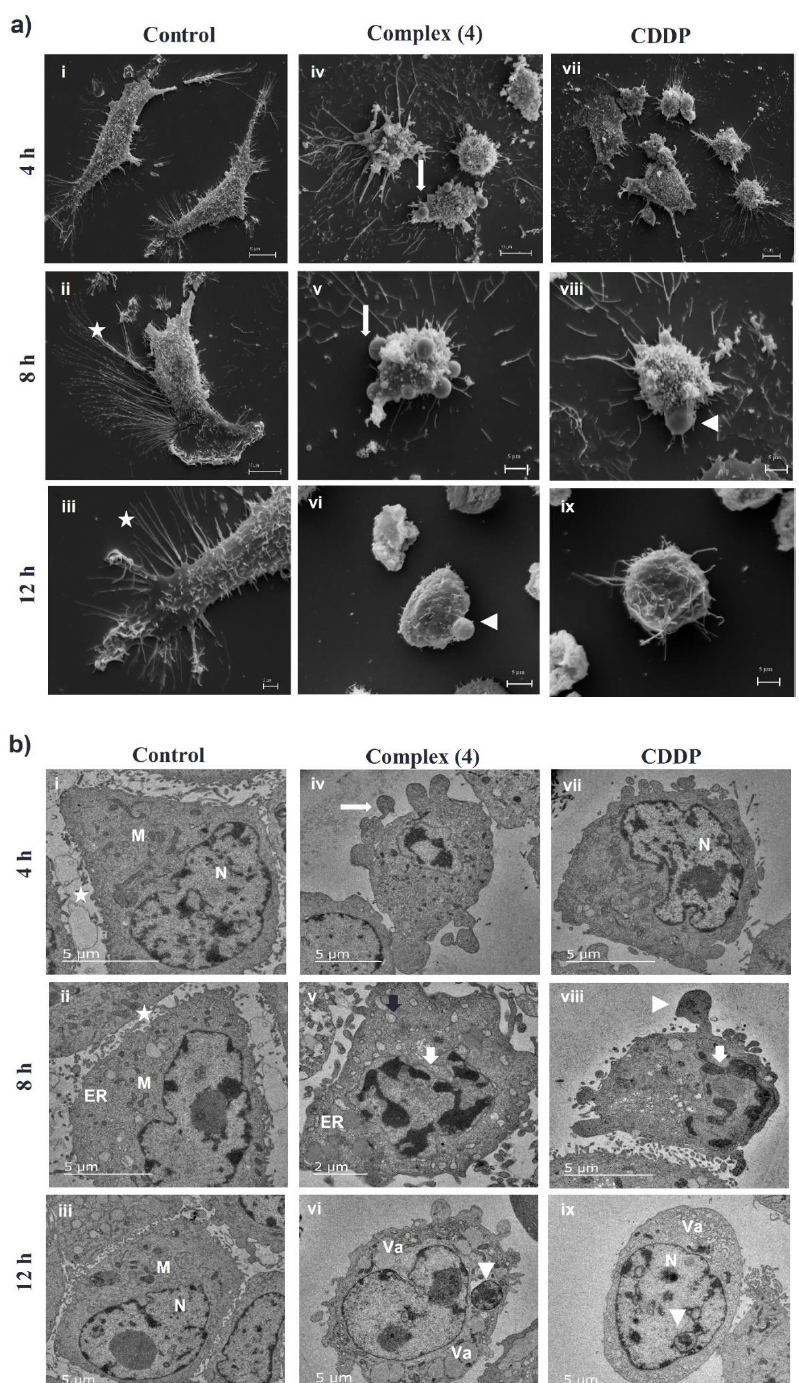
Figure 6. Ultrastructural analysis of MDA-MB-231 cells treated with 2 × IC 50 of complex ( 4 ) and cisplatin after 4, 8, and 12 h of incubation in comparison to the controlled group. ( a ) The top panel shows representative SEM micrographs of the compounds’ effect on the surface of the MDA-MB-231 cell line. ( b ) The bottom panel shows representative TEM micrographs of the compounds’ effect on the intracellular organelles of MDA-MB-231 cell line. Numerous villi are shown (star) on the cell surface. Cells with intense membrane blebbing (thin white arrow). The release of apoptotic bodies can be seen (arrowhead). Empty mitochondrial matrix (black arrow). Cells have a cytoplasm diffuse vacuolization and contain a reduced number of organelles (Va). (M) Mitochondria; (ER) endoplasmic reticulum; (N) nucleus. Chromatin condensation is indicated by the white